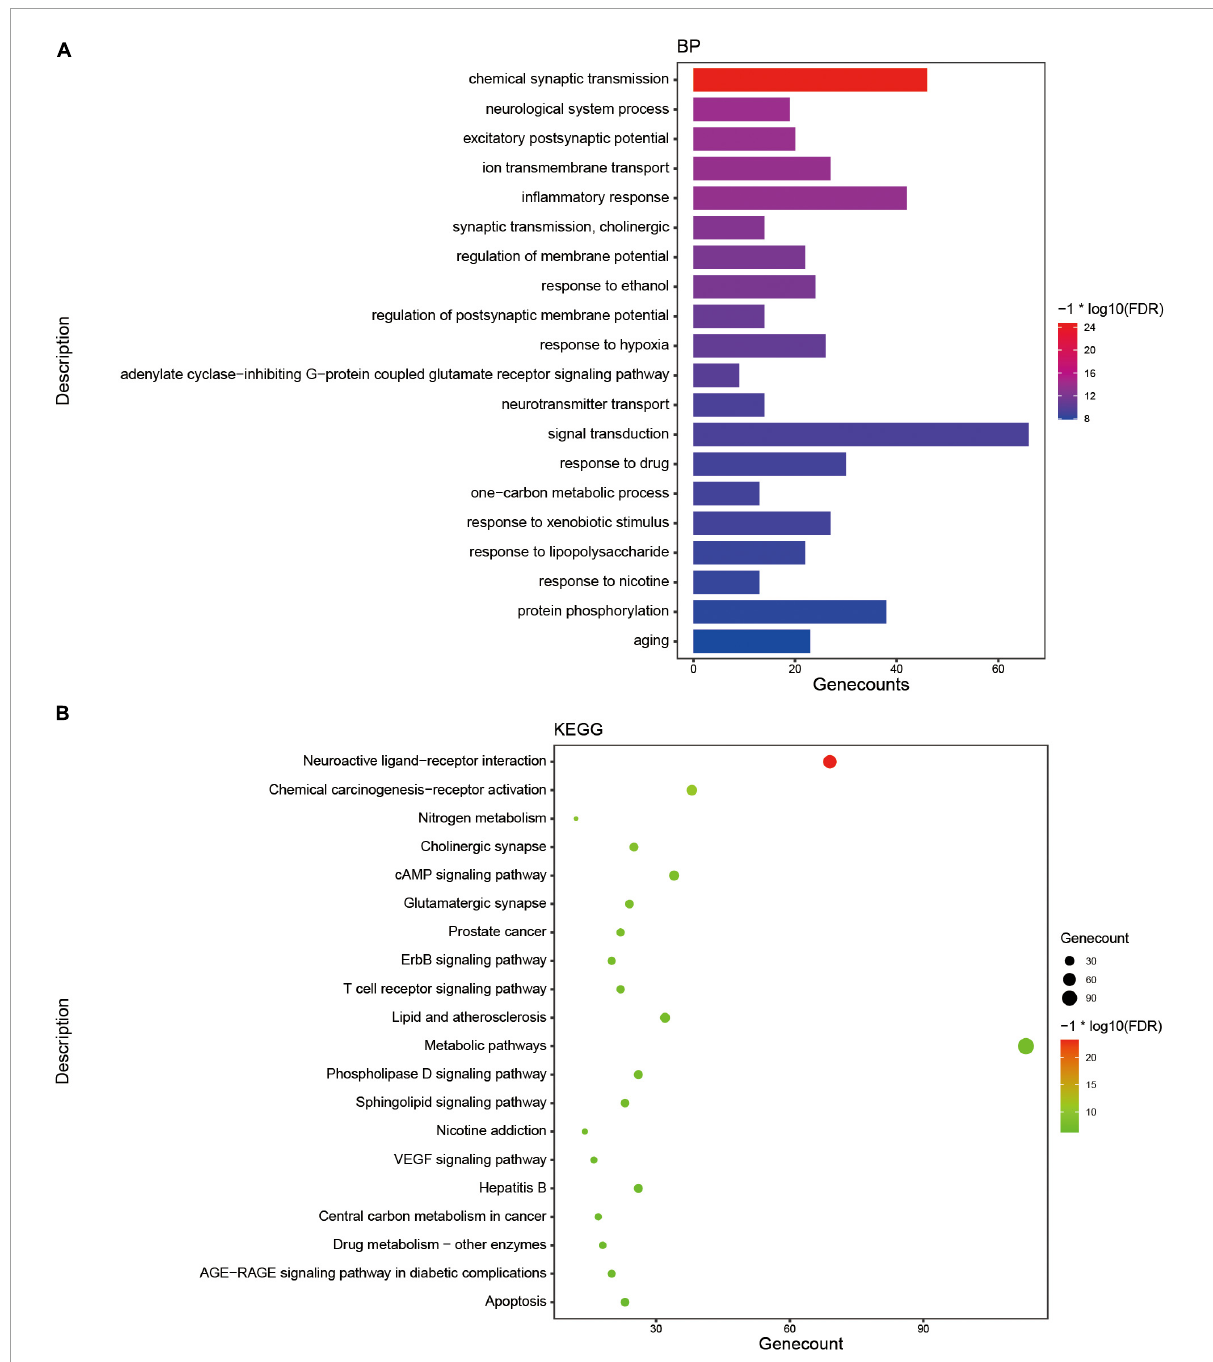
FIGURE3 The enrichment analysis of targets of active components from Tremella aurantialba . (A) Histogram of GO enrichment analysis of targets. (B) Bubble chart of KEGG enrichment analysis of targets.